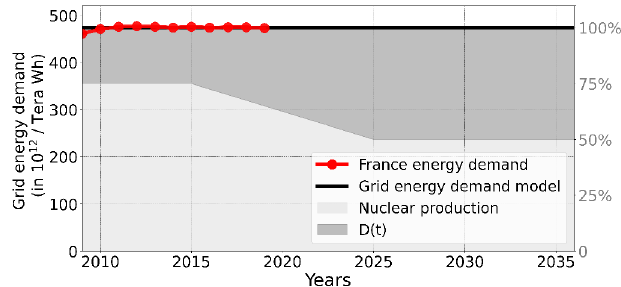
Fig. 2. Representation of the energy demand of France (red dot), the associated linear model (gray line), the scenario of the nuclear French production according to the “energy transition law” of 2015 (area in light gray) and the resulting low-carbon energy demand D ( t ) (area in